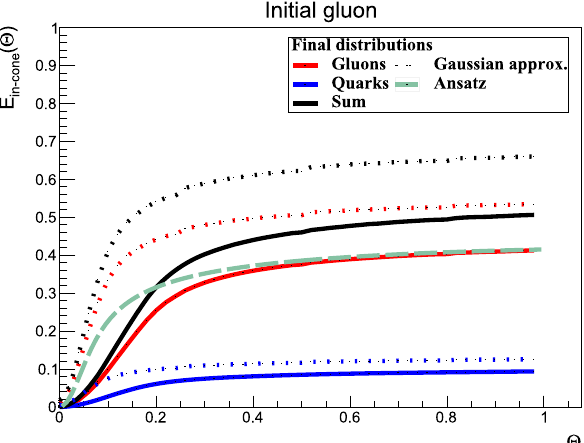
Eq. (50) (dotted lines) and analytical ansatz in Eq. (47)(green dashed line). The curves for the analytical Ansatz are plotted only in the case of pure gluon